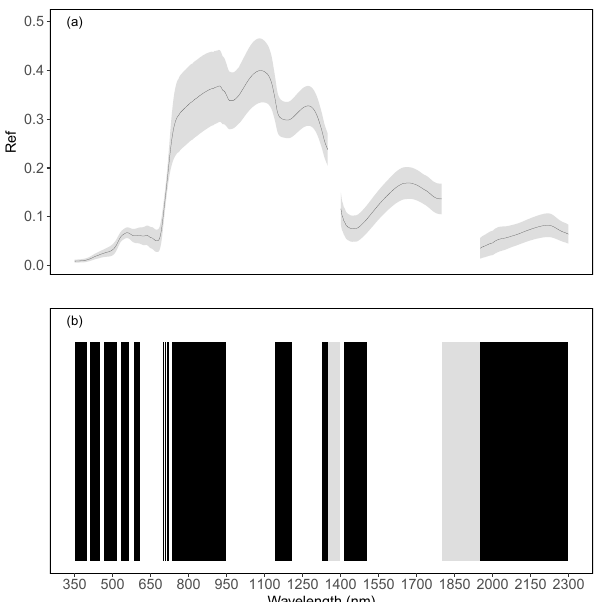
Figure 5. Average reflectance values and standard deviation (grey ribbon) observed in herbaceous plots undergoing different fertiliza- tion treatments (a) . The bottom picture (b) shows the bands ob- tained by grouping Ref for similarity ( r > = 90%) of contiguous hyperspectral measurements with 1nm resolution in the range 350– 2300nm; bands are alternately in black and white. Grey bars repre- sent noisy regions of the spectrum not considered in the